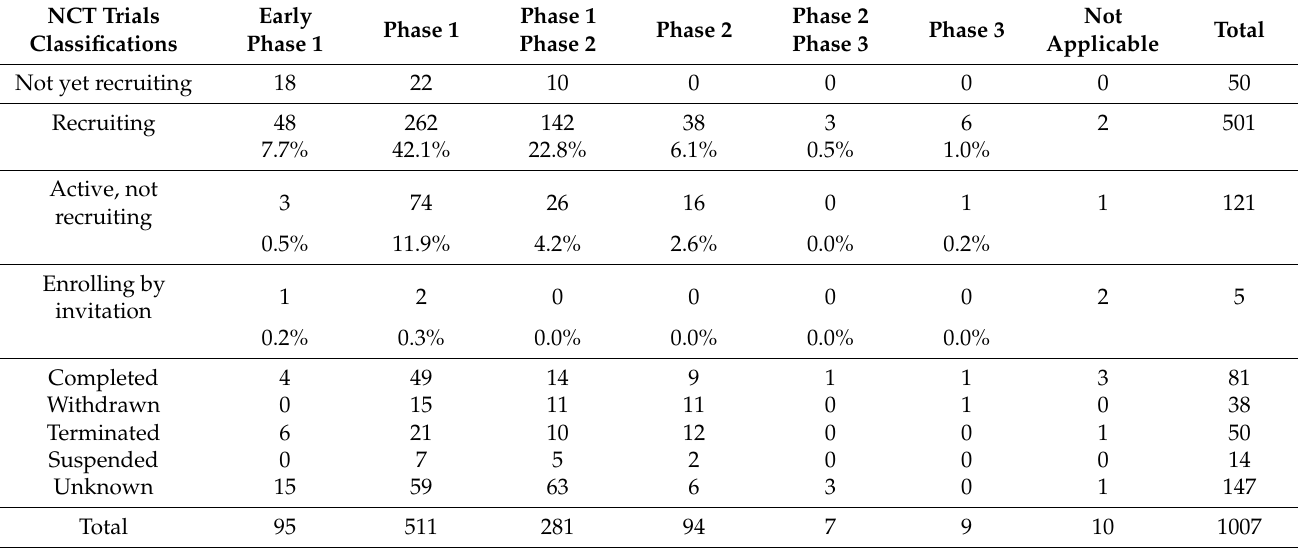
Table 1. Phase and status of all CAR-T/TCR-T trials registered on clinicaltrials.gov with start dates on or before. NCT Trials